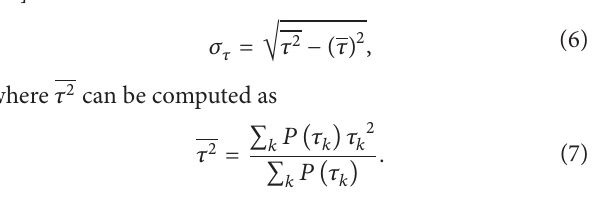
obtained from floor 2, with both Tx and Rx located at the center of the corridor at a height of 1.4 m. In Figure 7, the triangles and the dashed black line represent all the original measurement results and the mean value of these measured data points, respectively. The solid black line shows the results simulated by the ray-optical model. The selected position and direction of the antennas can also be found in Figure